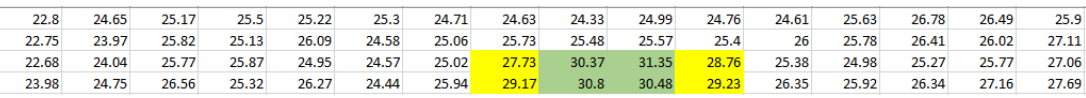
Figure 2. Window of 2 × 3 on a data